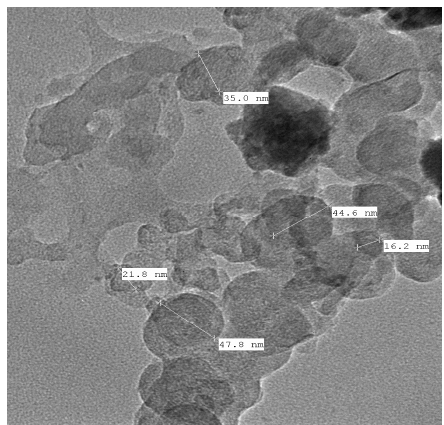
Figure 2. Transmission electron micrograph (TEM) of graphene Th(IV) phosphate cation exchanger.